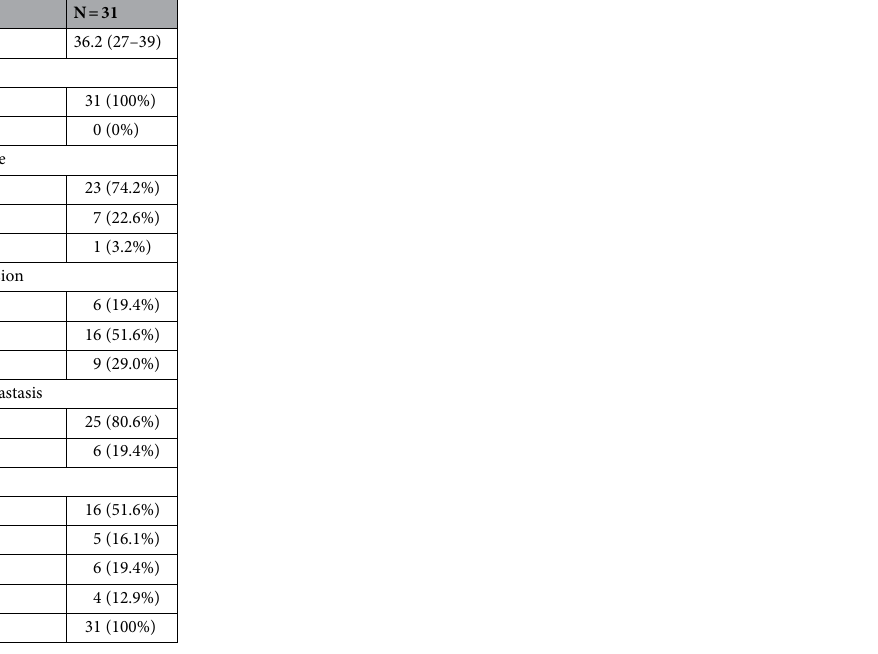
Table 1. Patient